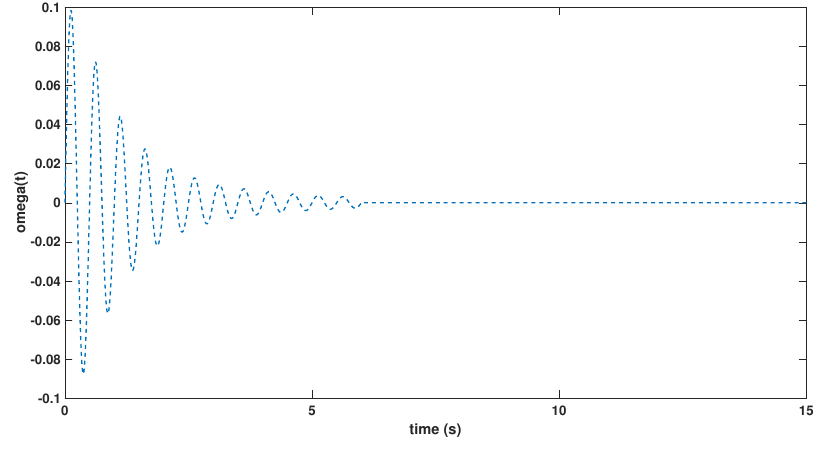
Figure 10. The response of disturbance signal.